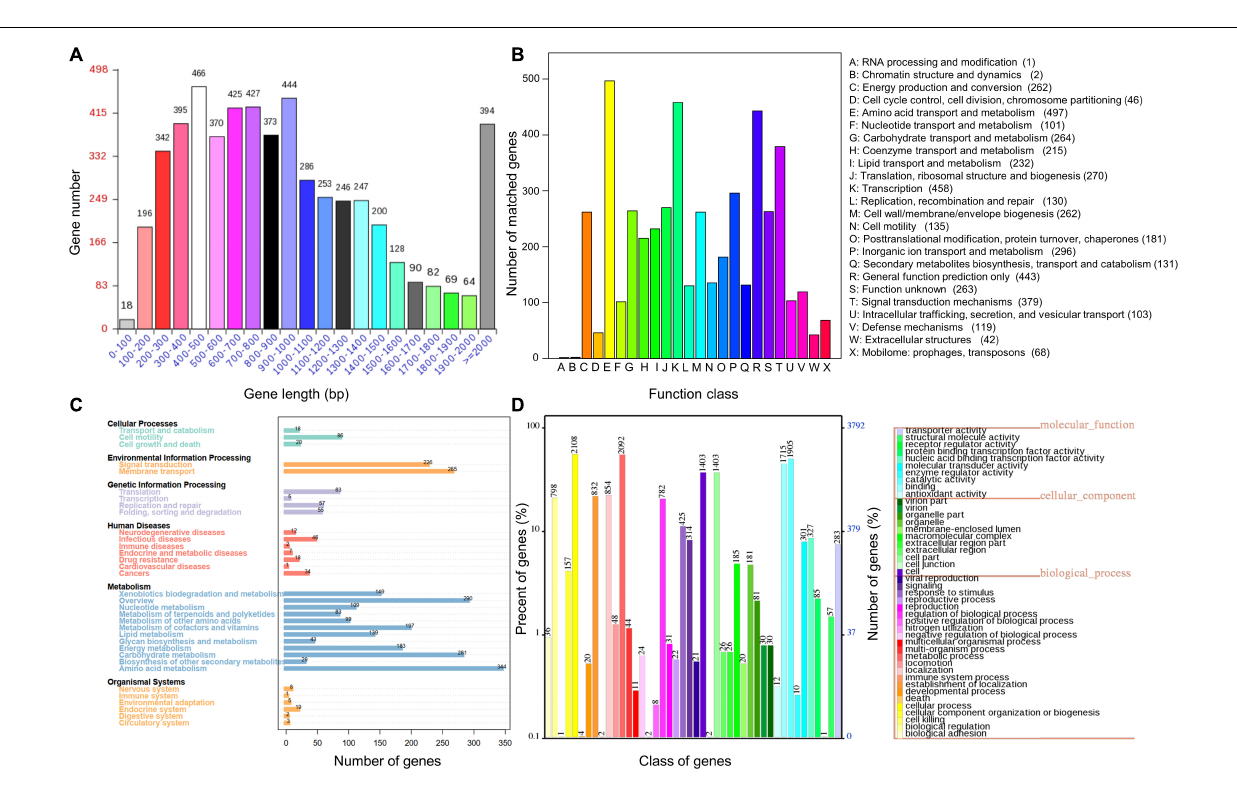
FIGURE 3 | Distribution of gene sizes in Pseudomonas fluorescens PF08 (A) and the functional categories annotated using COG (B) , KEGG (C) , and GO (D) .